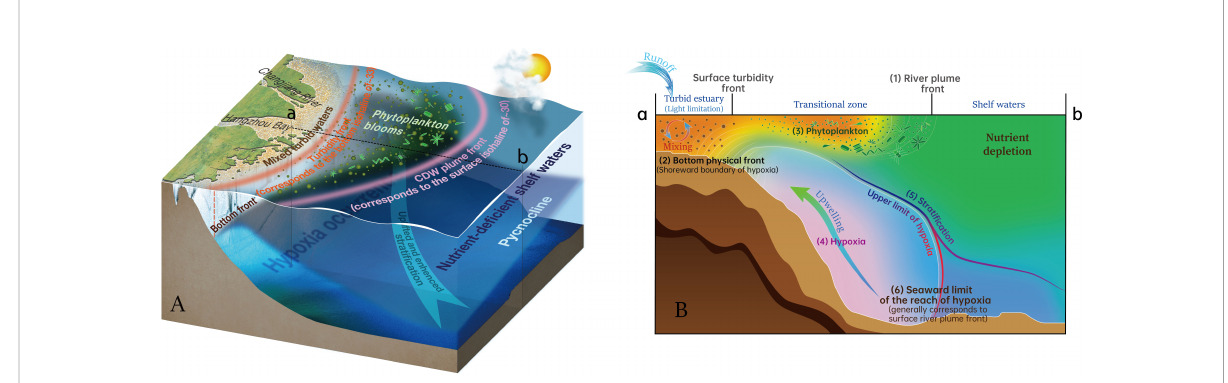
FIGURE 12 Conceptual diagram of spatially variable hypoxia shaped by multiple controls off the CE in summer, illustrating the (A) three-dimensional and (B) sectional (along the section ab in panel A) regimes. The indicated processes in panel B: (1) the sigini fi cant surface front forms around the CDW plume; (2) the bottom physical front corresponding to the shoreward boundary of bottom saline water under tidal mixing generally determines the location of surface turbidity front and the inner boundary of bottom hypoxia; (3) phytoplankton blooms tend to be situated in the transitional space between the spatially separated dual fronts of surface river plume and turbidity, due to nutrient availability (contributed by the plume and coastal upwelling) and improved light conditions; (4) hypoxic waters are mainly concentrated on the steep region off the CE and tend to be uplifted shoreward; (5) the depth of strati fi cation and its spatial variability, which are mainly shaped by river plume and upwelling interaction, play a dominated role in determining the upper boundary of the hypoxic zone; (6) the surface river plume front approximately corresponds to the seaward limit of the reach of bottom